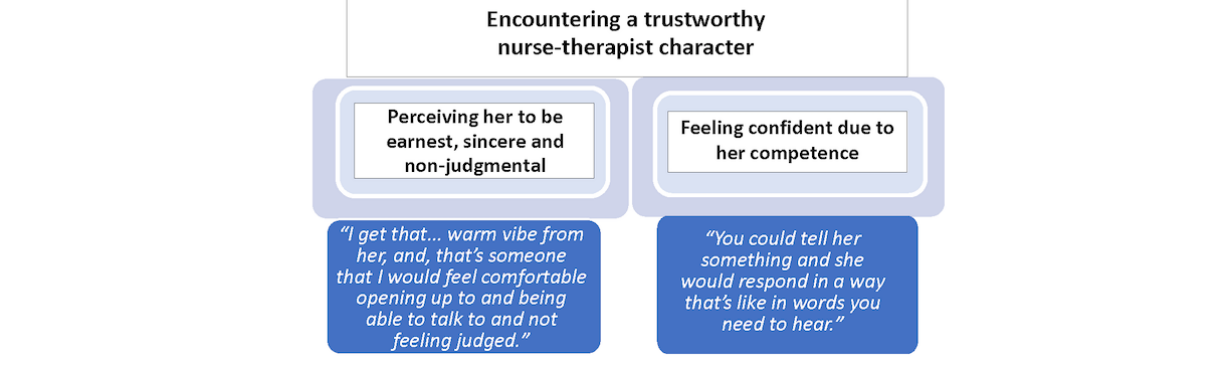
Perceiving Her to be Earnest, Sincere, and